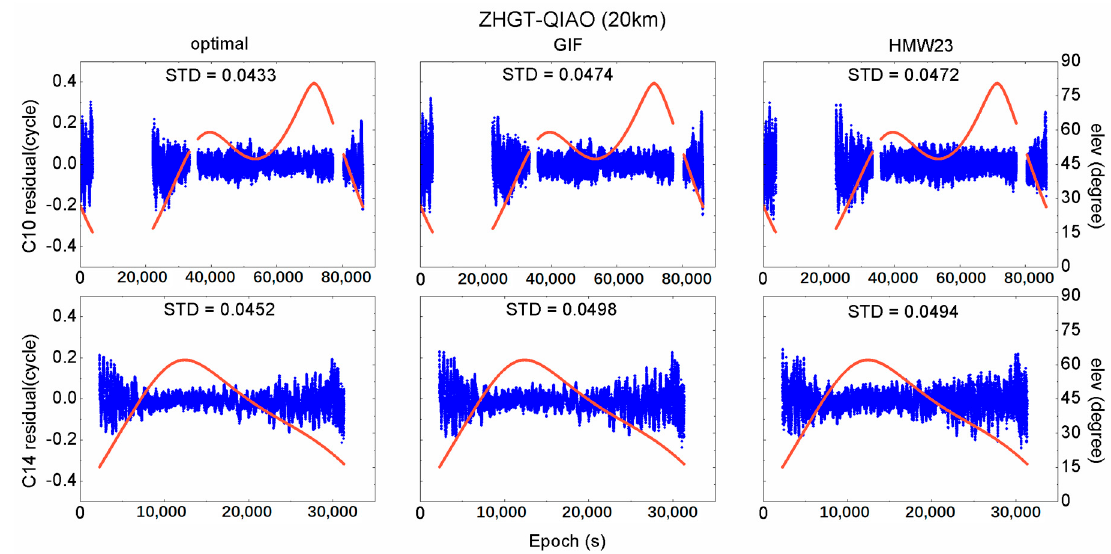
Figure 2. Comparison of ambiguity residuals and the corresponding standard deviations of optimal , GIF , and HMW23 combinations for the medium baseline (20 km).